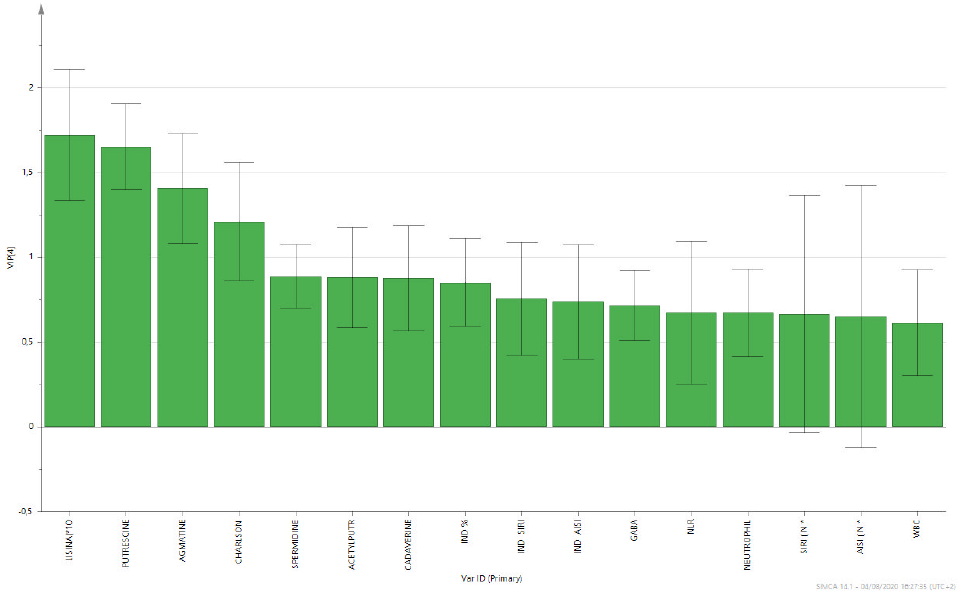
Figure 4. Factors with the highest VIP scores and contributory variables in class discrimination in the PLS-DA model.